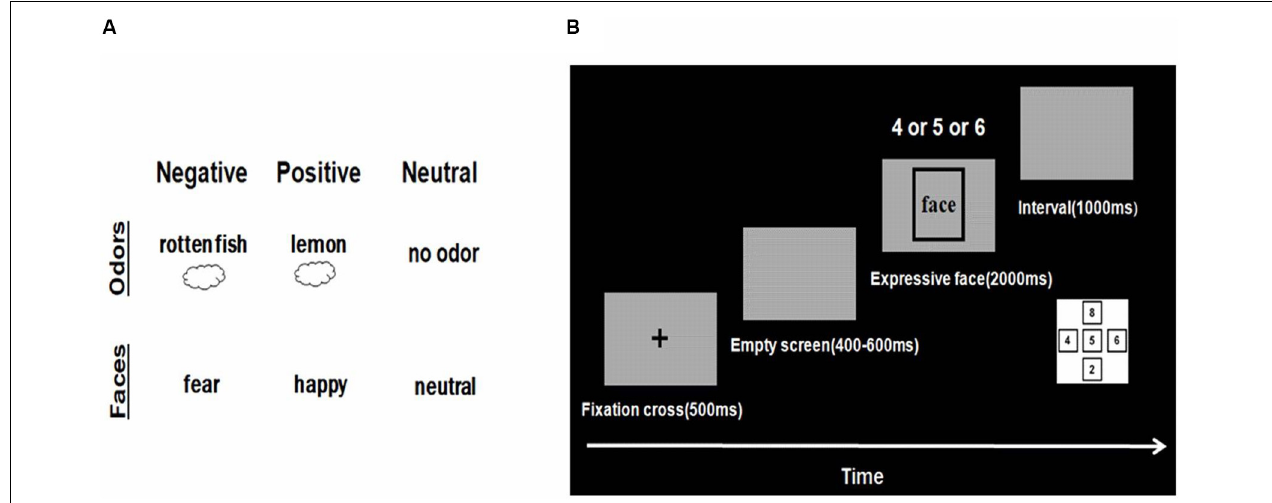
FIGURE 1 | Materials and Procedure. (A) Representative odors and faces used in the experiments. (B) Time sequence for the experimental trials. Subjects first saw a fixation cross for 500 ms. Next, an empty screen appeared for 400–600 ms. Then a picture was presented for 2000 ms, followed by presentation of an empty screen for 1000 ms before the subsequent trial was initiated. The study had a 3 × 3 factorial design, resulting in the presentation of 9 odor–face combinations (each consisting of 20